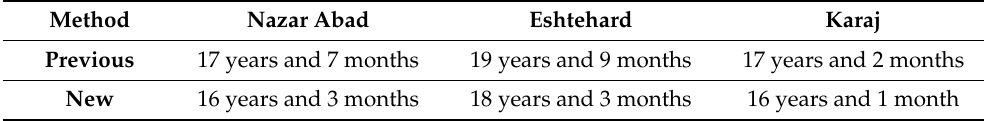
Table 1. Comparison of implementing this method with the previous methods.